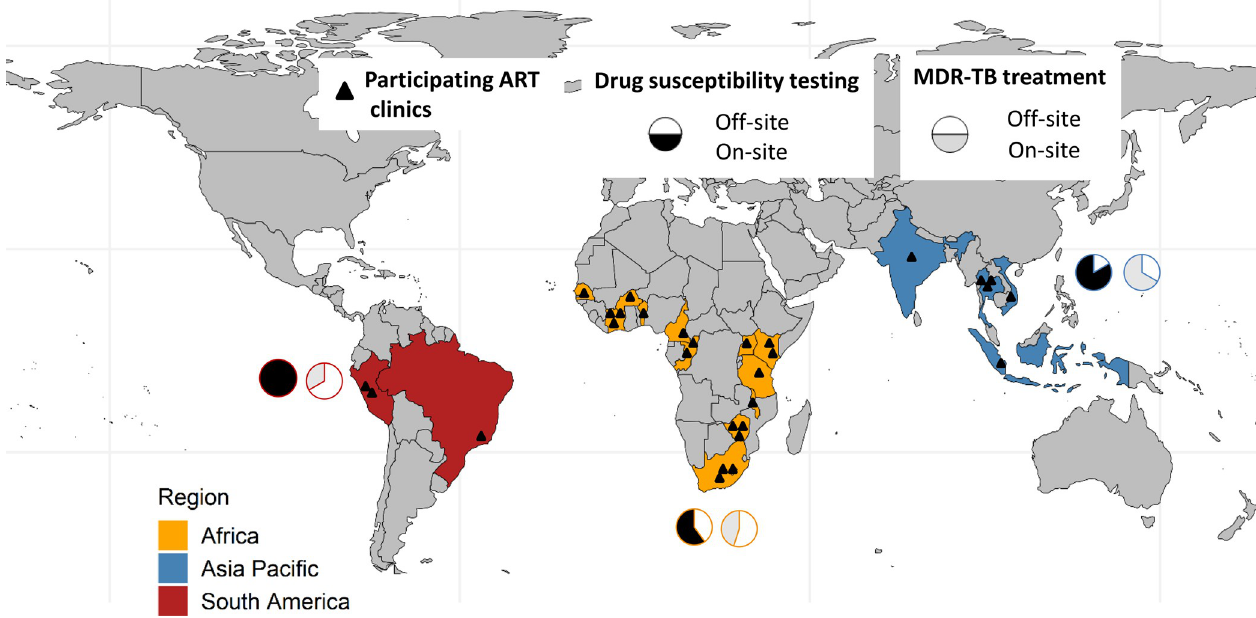
Fig 1. Map showing the participating ART clinics by regions. Pie charts indicate the proportion of clinics with drug-susceptibility testing (DST) (black) and MDR-TB treatment (grey) available on-site by region. Types of DST available included Xpert MTB/RIF, line probe assay, and culture. Abbreviations: MDR, multidrug resistance; TB,